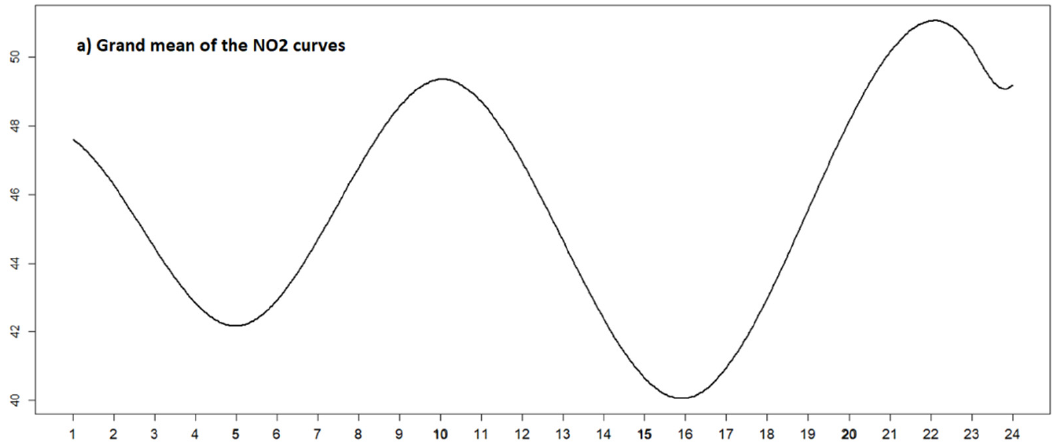
Figure 4. The observed versus predicted plot for ( a ) the validation station of district 11 that had the worst prediction based on the RMSE metric in Table 2. ( b ) The validation station of district 10 that had the best prediction based on the RMSE metric in Table 2; bold curves show the prediction of the OKFD model for that station and the red dots show the corresponding observed hourly data.